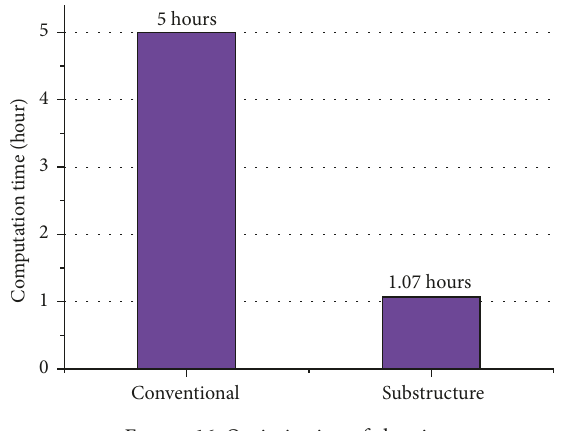
Figure 16: Optimization of chassis.